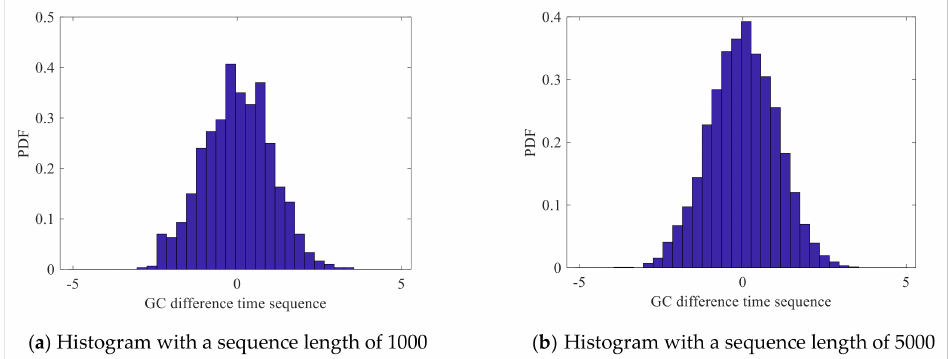
Figure 4. The histograms of GC difference time sequence.